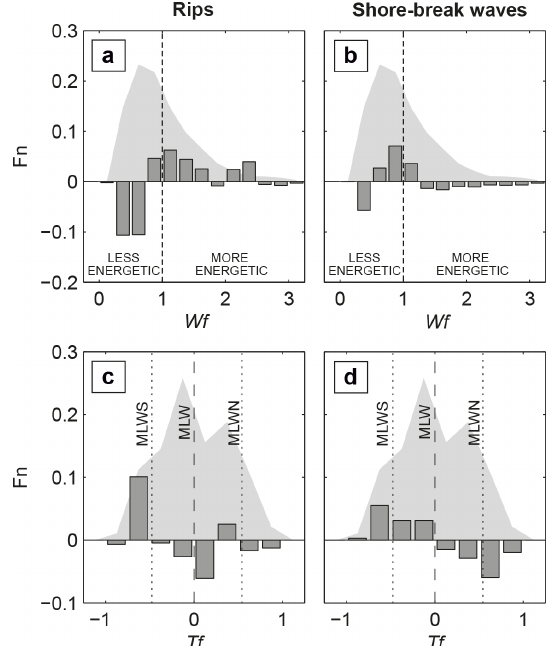
Figure 13. Normalised frequency distributions, Fn , of (a, b) Wf (wave factor = HsT 02 /HsT 02) and (b, d) Tf (tide factor = LW − LW ) associated with (a, c) rip-related injuries and (b, d) shore- break-related injuries. Dark grey bars are the difference between the incident-related and the “average” background frequency dis- tributions, positive values are the proportion of the incident-related distribution greater than the background. In panels (c) and (d) the dashed lines indicate mean low water spring (MLWS), mean low water (MLW) and mean low water neap